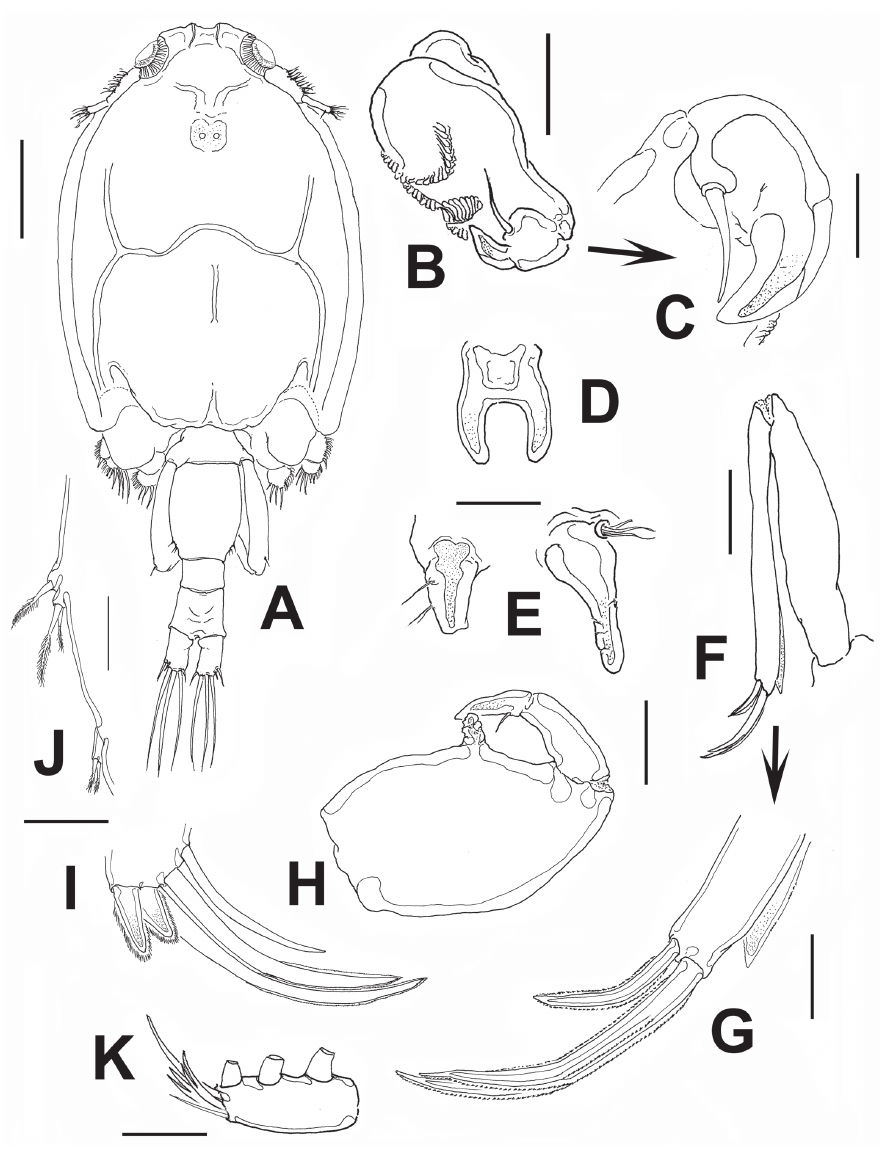
Figure 3. Caligus evelynae sp.n., adult male from Venezuela: A habitus, dorsal view B antenna C detail of distal part of antenna D sternal furca, ventral view e postantennal process and maxillule F maxilla G detail of calamus and canna h maxilliped I fourth leg, detail of distal elements J fifth and sixth legs K first leg, distal segment of exopod. Scale bars: A =0.5 mm, B,D–F, H =0.1 mm, C, G, I, J =0.03 mm; K =0.07